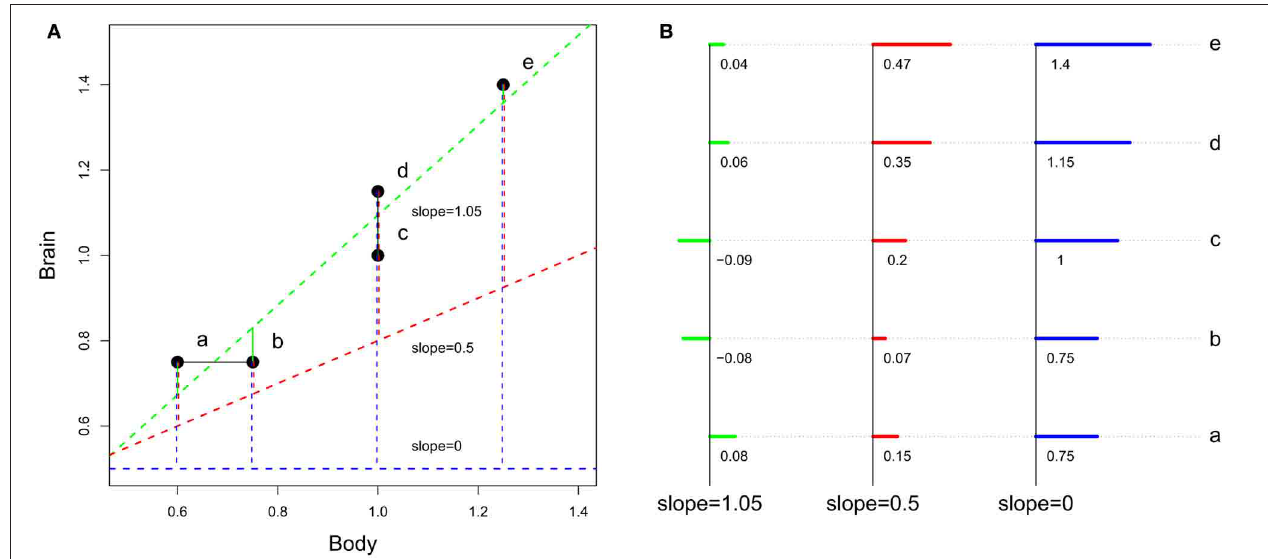
FIGURE 6 | Differences between encephalization quotient and absolute size in estimating species cognitive capacities. (A) Representation of the slopes. (B) Detail of the residuals (the scale is not respected between the 3 cases). At slope equals 1.05 (slope obtained by a regression of hypothetical brain and body size), encephalization quotient is insensitive to brain size. At slope between 0 and 1, encephalization quotient is sensitive both to absolute